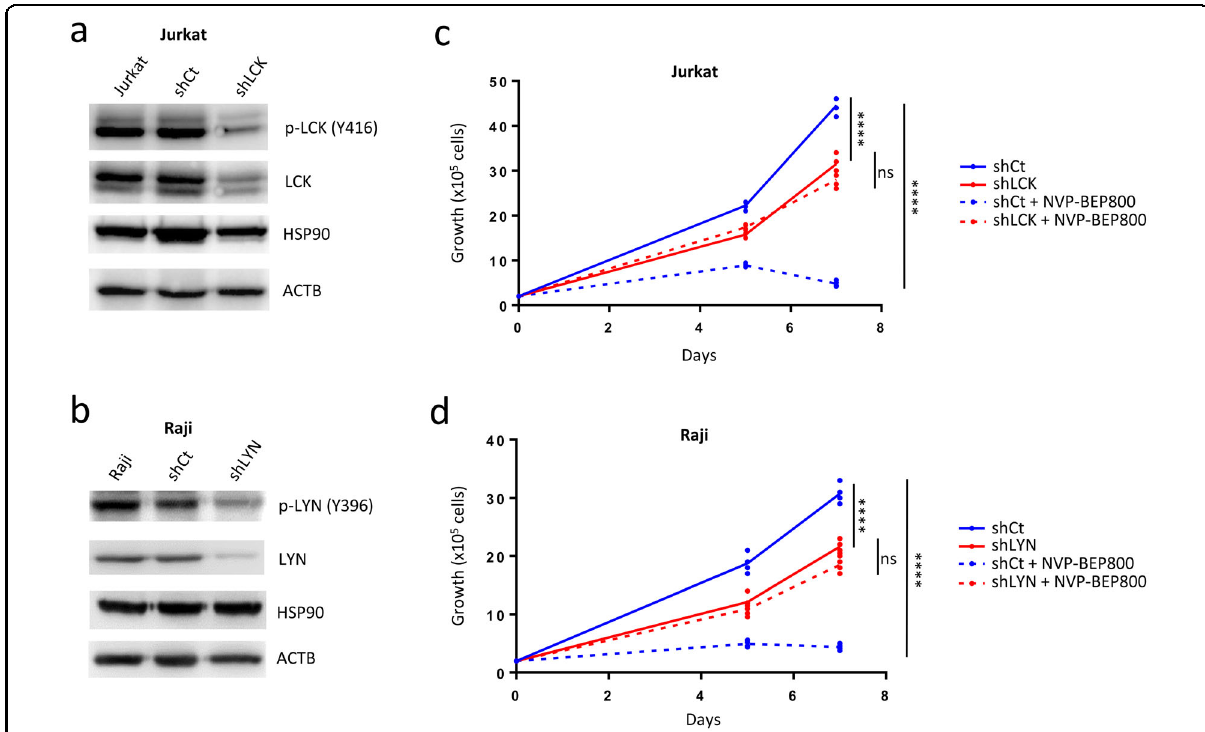
Fig. 2 Downregulation of LCK and LYN kinases inhibits NVP-BEP800 ef fi ciency on T and B lymphoblast cell lines. Western blot shows low levels of expression of p-LCK and total LCK after the viral transduction of Jurkat cells with shLCK ( a ), or p-LYN and total LYN after the viral transduction of Raji cells with shLYN ( b ). Cell growth assay shows no sensitivity of shLCK Jurkat cells ( c ) and shLYN Raji cells ( d ) to NVP-BEP800. 2 × 10 5 viable cells (trypan blue negative) are seeded. Cells are treated with NVP-BEP800 (1 µM) at days 0 and 5. Data are shown as mean; n = 3 biological replicates for T-ALL and n = 4 biological replicates for B-ALL. P value measured by one-way Anova test with Tukey ’ s multiple comparison test; **** P < 0.0001; ns, non-signi fi